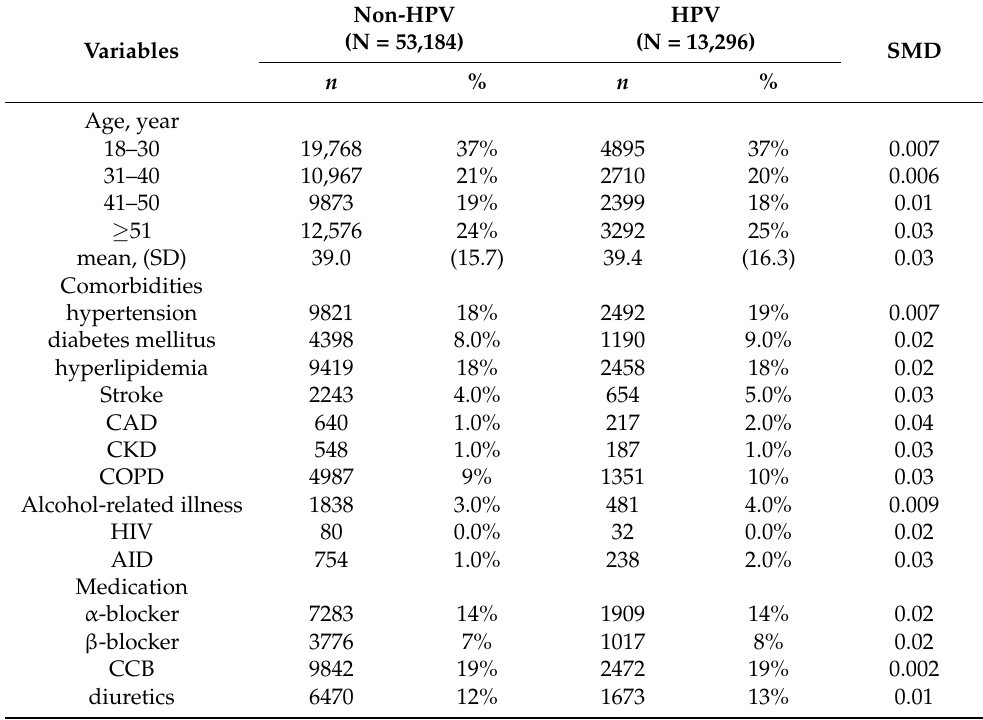
listed in Table 1. The Kaplan–Meier method was used to plot the cumulative incidence curves of ED for the HPV and non-HPV groups. Differences between the two groups were evaluated by the log-rank test. The incidence rates of ED were estimated by dividing the number of events by follow-up person-years for both groups. Two statistical models were fitted to evaluate the effect of HPV on the risk of ED (Table 2). In model 1, we examined the temporal relationship between HPV exposure and the risk of developing ED for both groups, adjusted for age, co-morbidities, and co-medications at baseline. Model 2 was adjusted for all covariates in model 1, and further adjusted for relevant operations associated with subsequent ED to minimize confounding, (e.g., foreign body entering through an orifice, low anterior resection, and abdominoperineal resection) [61–63]. Subgroup analyses were conducted to reveal the potential interaction effect of sex, age, and follow-up between HPV infection and subsequent ED development. All data analyses were performed with SAS (version 9.4; SAS Institute, Inc., Carey, NC, USA). The statistical significance level was set at a two-tailed p -value of <0.05. Table 1. The baseline characteristics in patients with and without HPV. infection.